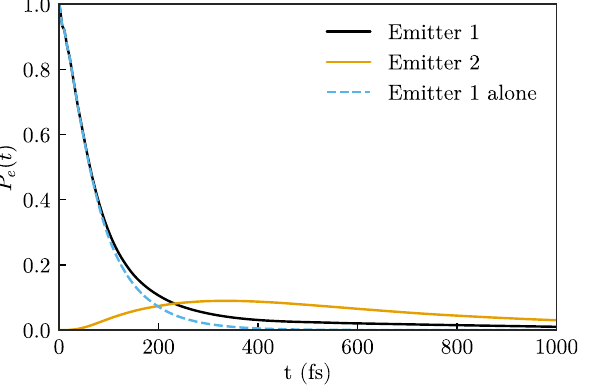
Figure 5: Time-dependent electric field intensity | E | 2 at position 3 in Figure 1, for the case when both emitters are present (black solid line) and when only emitter 1 is present (orange dashed